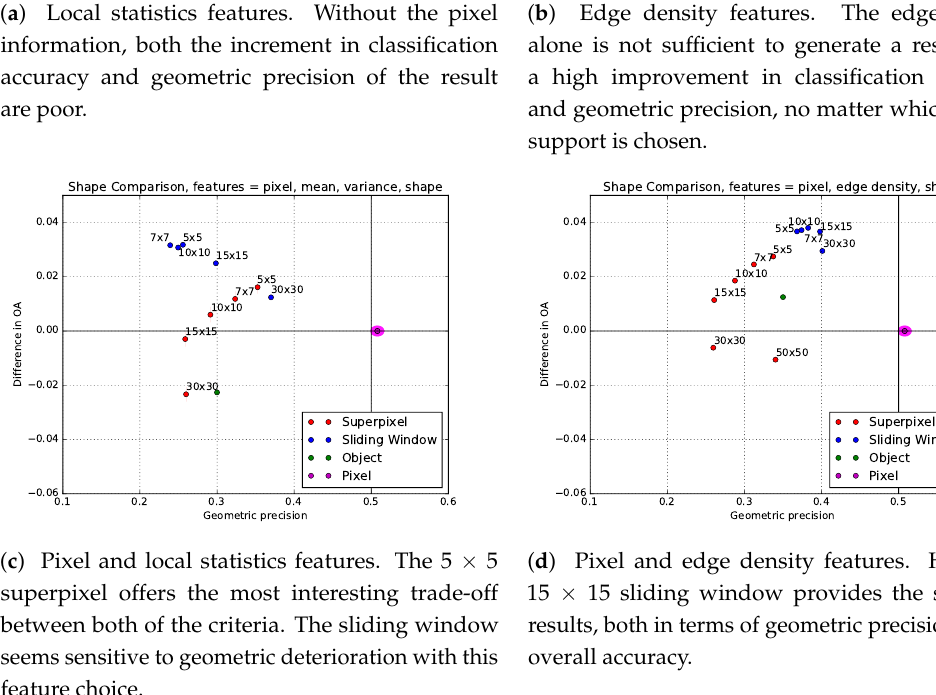
Figure 15. Differences in overall classification accuracy compared to the pixel-based classifiers, plotted against the PBCM, for the different combinations of features and spatial supports. Whenever relevant, the shape features were